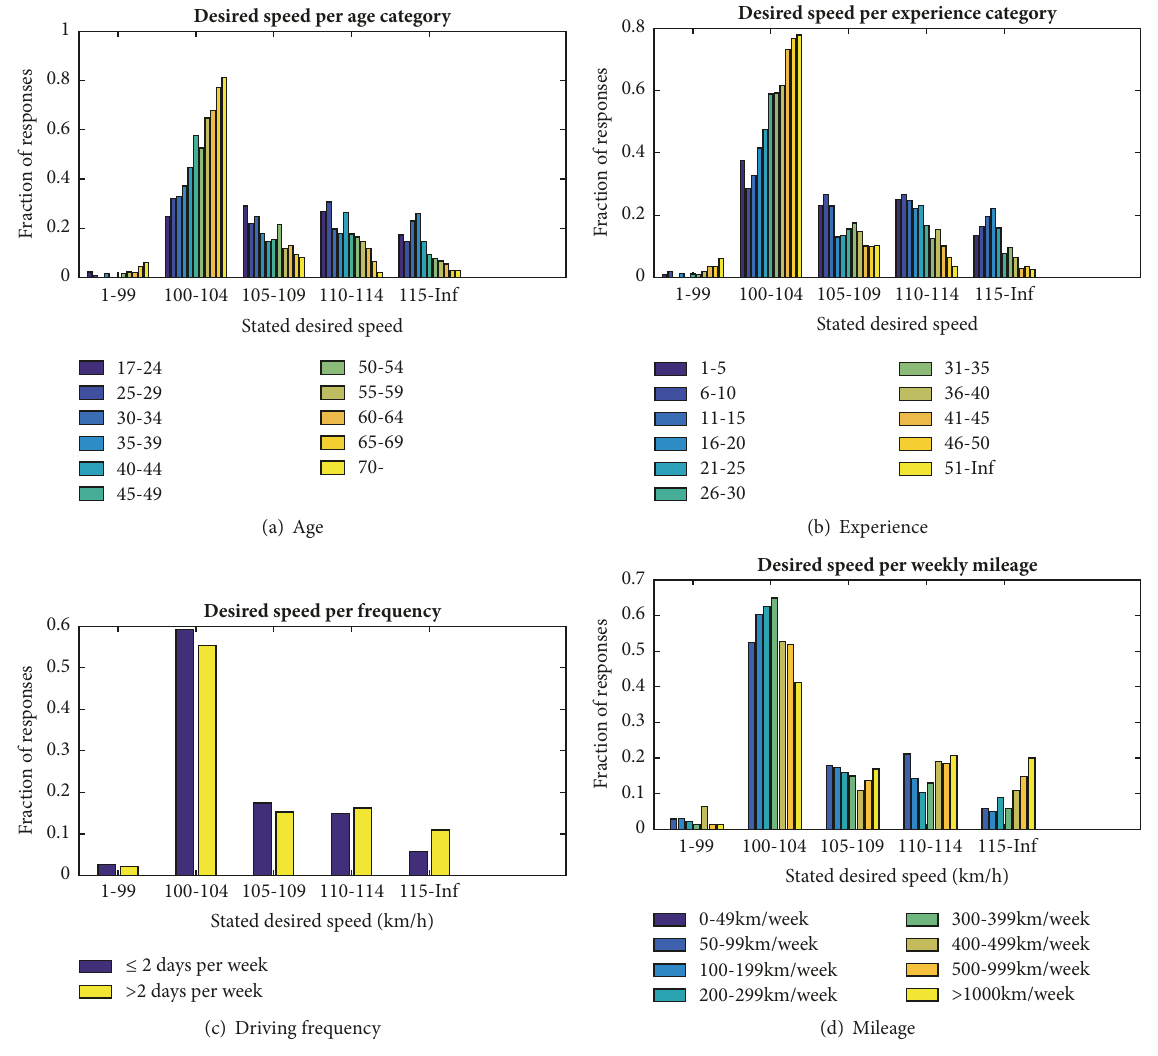
Figure 4: Overview of the impacts of various factors to desired